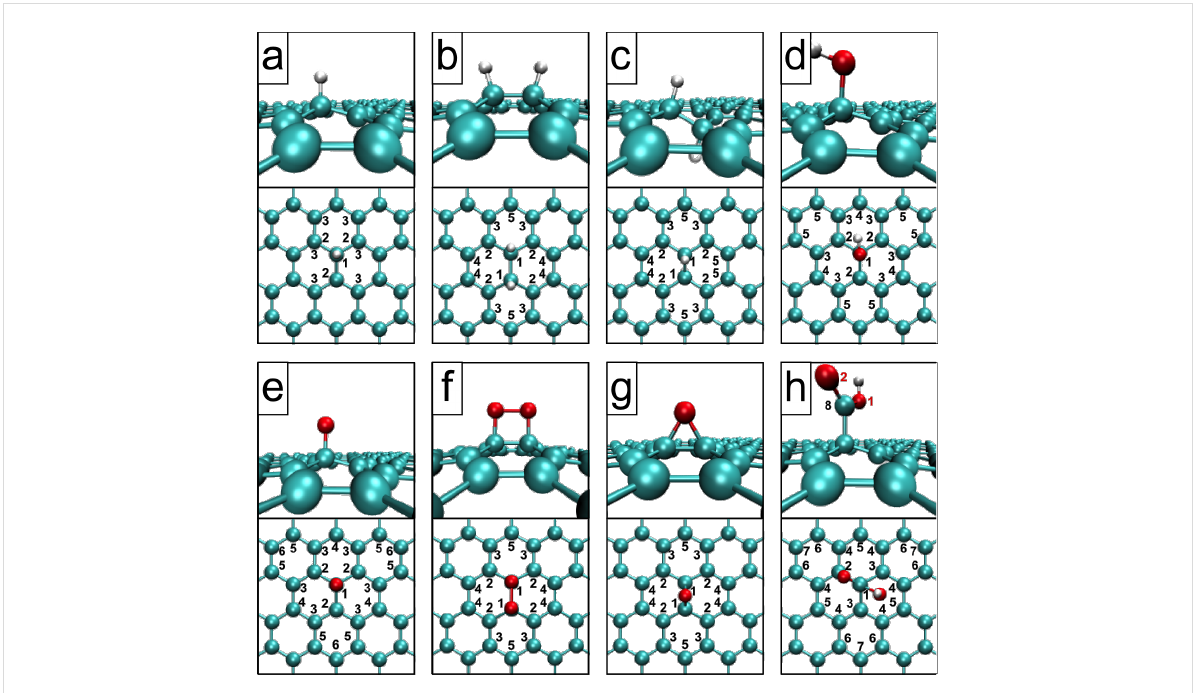
Figure 2: Cropped relaxed structures of functionalized graphene. The a) hydrogen (–H), b) dihydrogen (2 –H), c) graphene-like dihydrogen (2 –H opp ), d) hydroxide (–OH), e) oxygen (=O), f) dioxygen (–2O), g) epoxide (>O), and h) carboxyl (–COOH) functionalities.